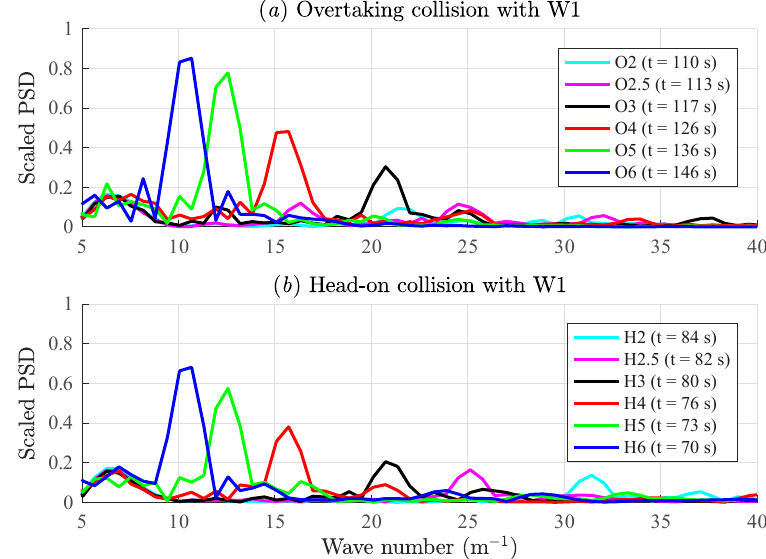
Figure 13. Scaled PSD of linear waves in the simulations with (a) an overtaking collision and (b) a head-on collision at T = 1.